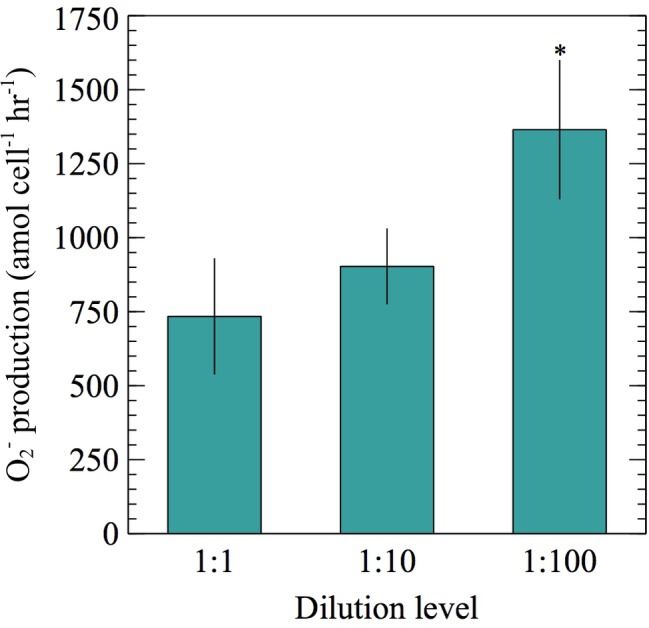
Net per-cell O2− production rates were measured from ~106
E. huxleyi cells during exponential growth phase post no dilution (1:1), 10-fold dilution (1:10), or 100-fold dilution (1:100) with 0.22 μm filtered, autoclaved seawater for 0–6.5 h. Significant differences (two sample Student’s t-test) relative to the undiluted control (1:1) are indicated by asterisks, where p < 0.05 is represented by * symbol. Error bars depict one standard error of the mean of replicates (n = 8 for 1:100 and 9 for 1:1 and 1:10 dilutions).